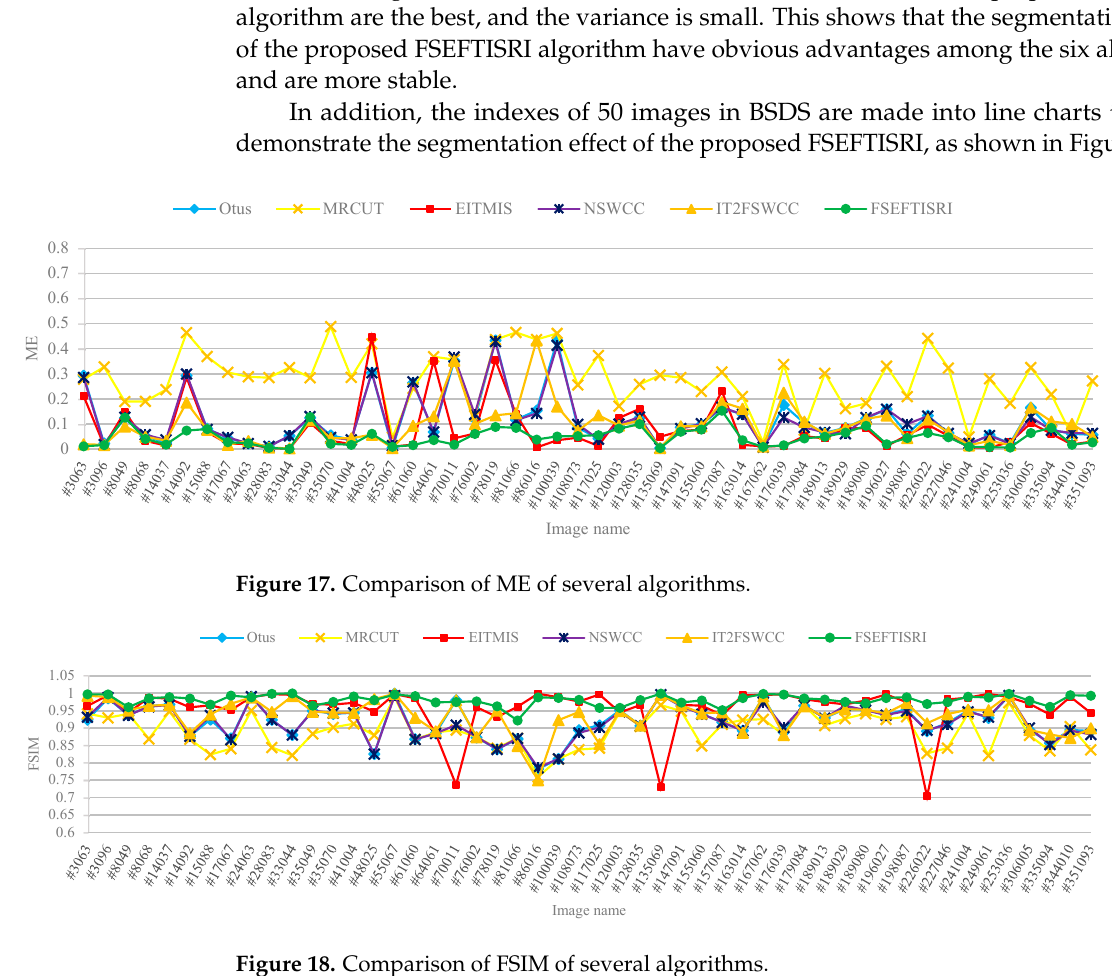
Figure 18. Comparison of FSIM of several algorithms.